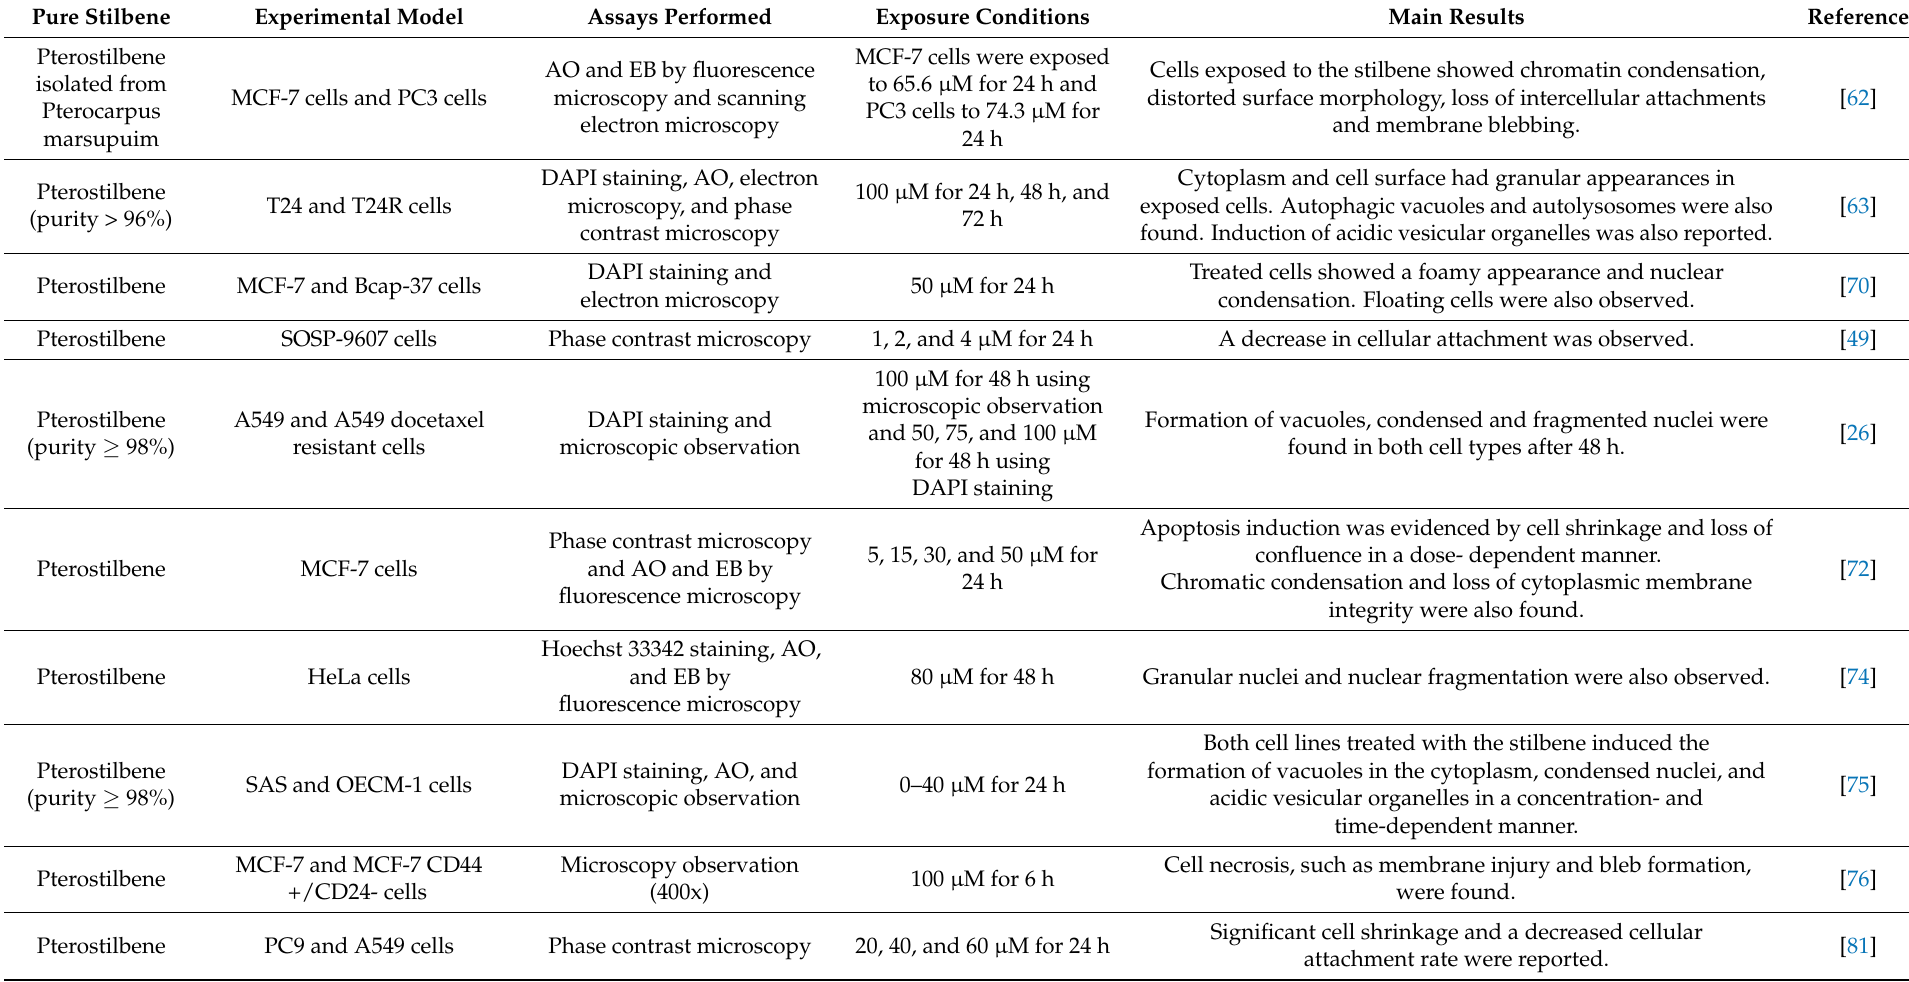
Table 4. In vitro morphological studies performed with